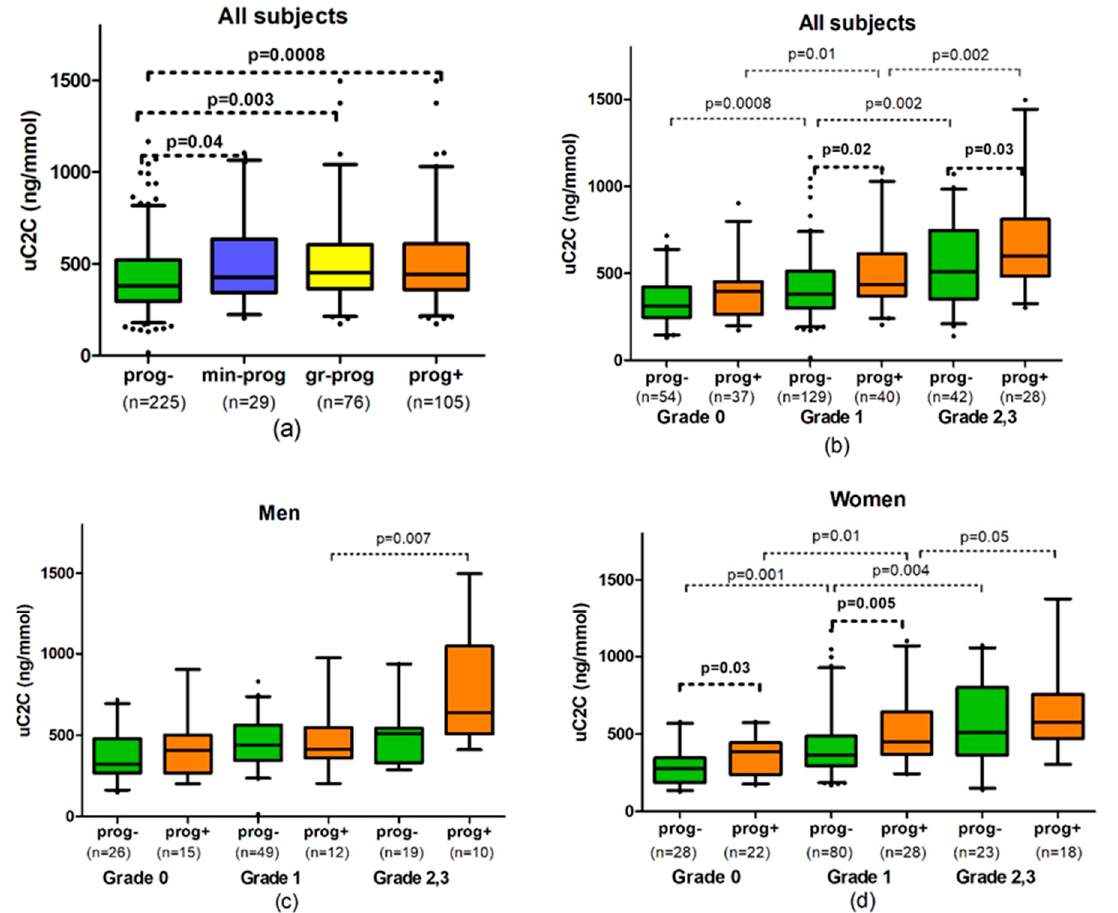
Figure 2. The association of uC2C with radiographic progression of knee osteoarthritis (kOA): ( a ) In all grades in summary; ( b ) in all subjects by global grade of kOA (gOA); ( c ) in men by gOA grades; ( d ) in women by gOA grades. Abbreviations: prog-—non-progressors, subjects without radiographical changes of kOA during 3 years; prog+—progressors, subjects with the progression of kOA; min-prog—minimal progressors, subjects with radiographic worsening of kOA within the same gOA grade; gr-prog—grade progressors, subjects with the progression of gOA ≥ 1 grade; n, numbers. Box-whiskers plot with 5th–95th percentiles, the p -value of Mann–Whitney U-test.